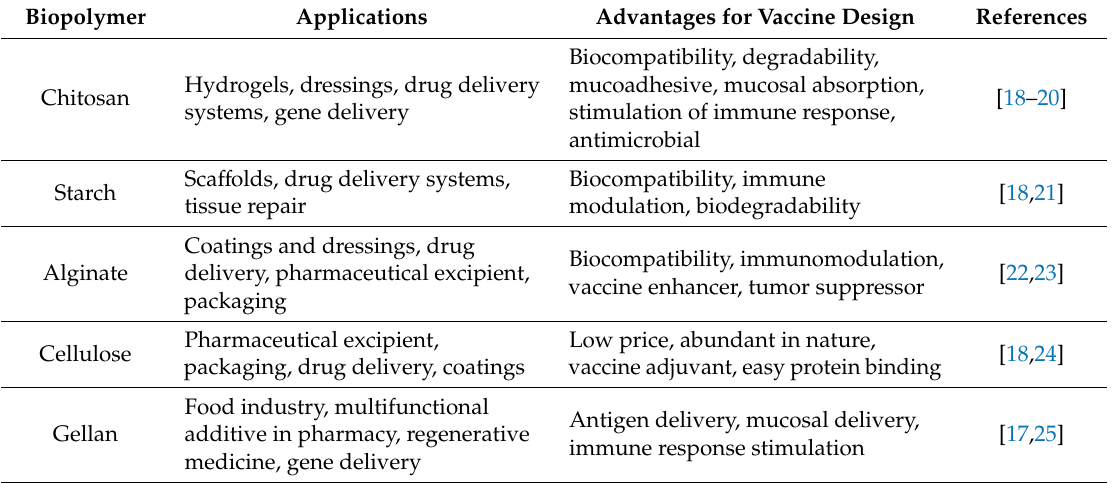
Table 1. Biopolymers with useful properties for vaccine